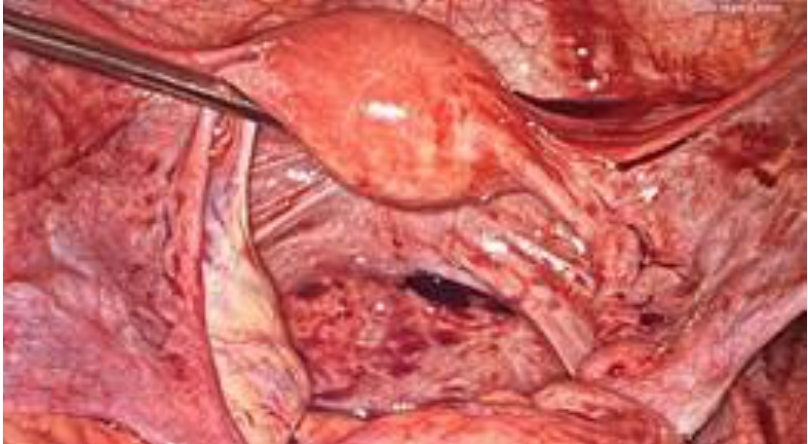
Figure 2. Peritoneal perforation in the right posterior fornix.